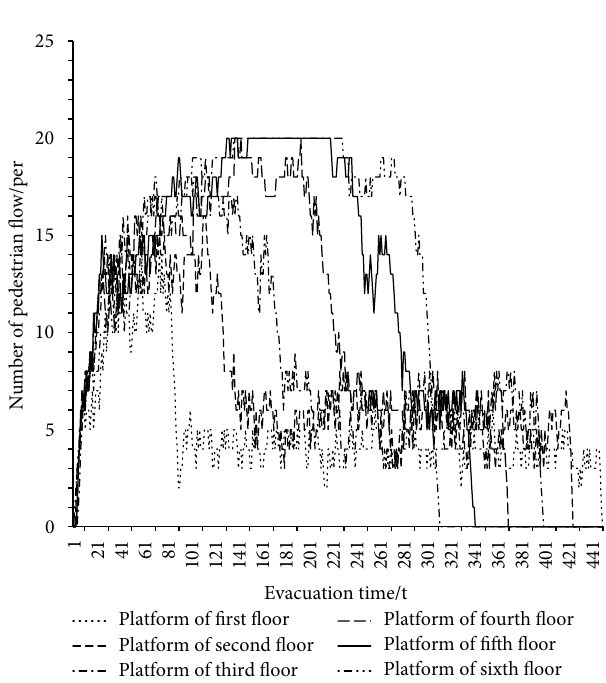
Figure 3: Flow output rate of floor platform.